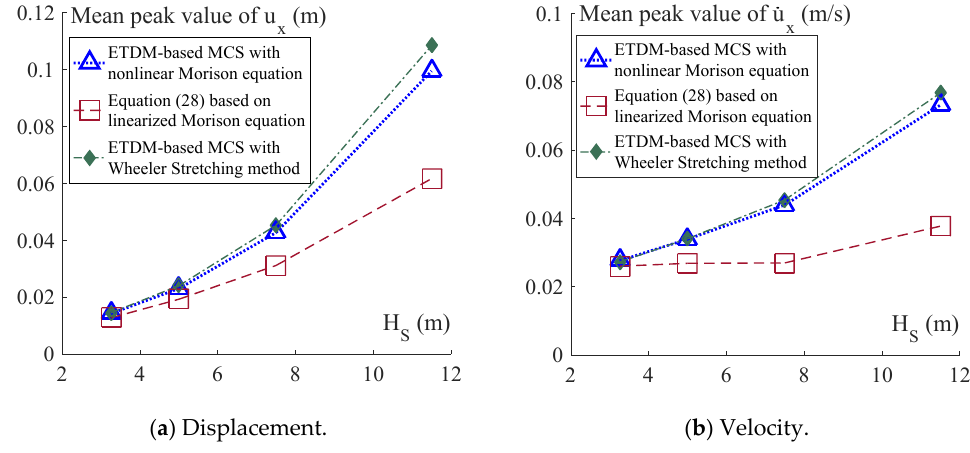
Figure 13. Mean peak values of the displacement and velocity at a top node of the jacket platform.